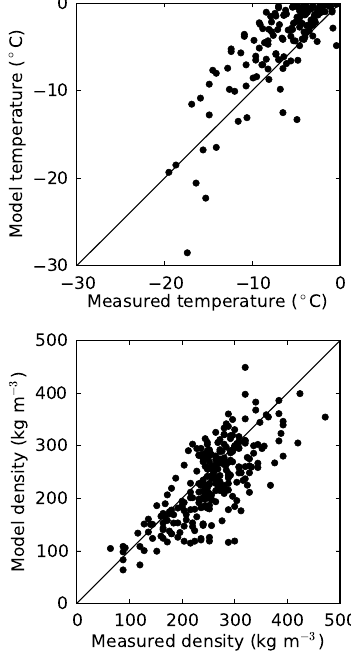
Figure 10. Scatter plots of Crocus simulations and manual snow pit measurements of snow temperature and density for the winter of